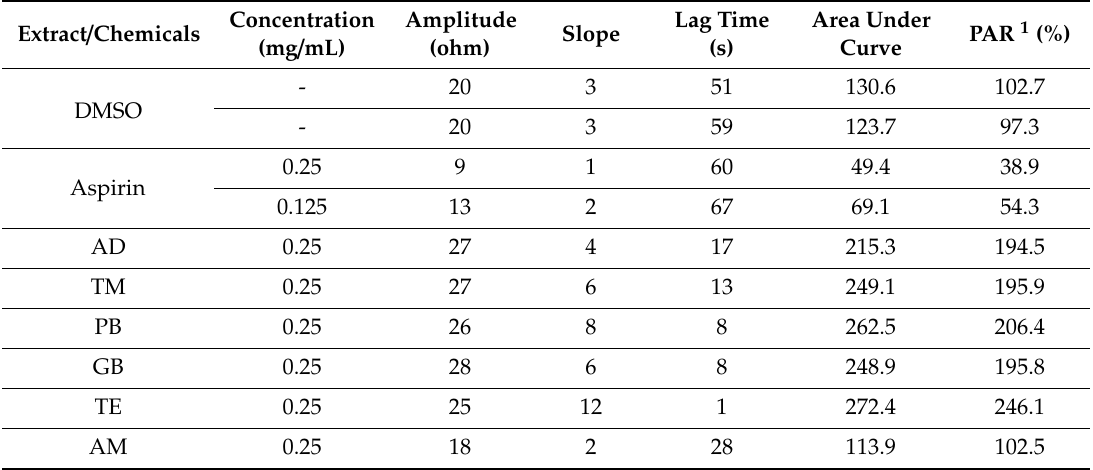
Table 4. E ff ect of the ethanol extracts of 6 di ff erent insect species on platelet aggregation. Extract / Chemicals